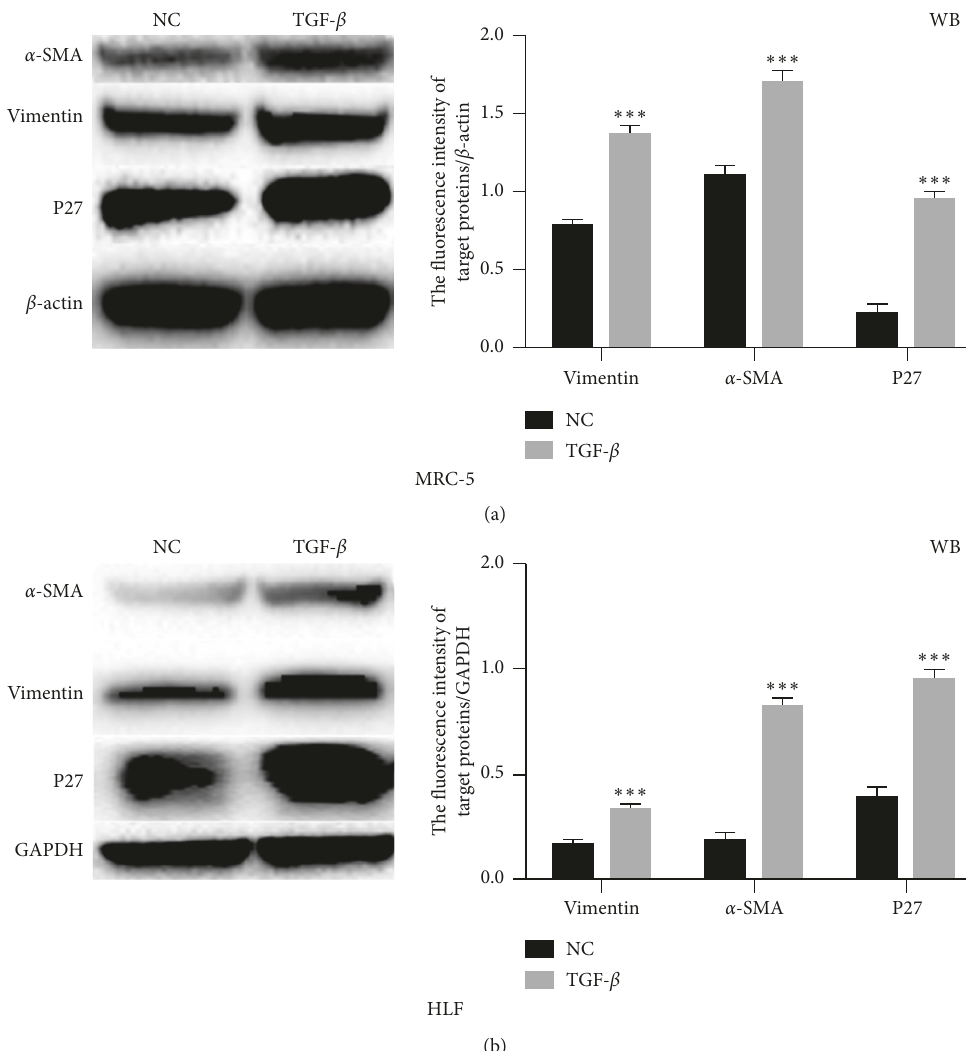
Figure 4: TGF- β promoted the expression of P27. (a, b) Western blot analysis of expression of a-SAM, vimentin, and P27 in MRC5 and HLF cells treated with TGF- β